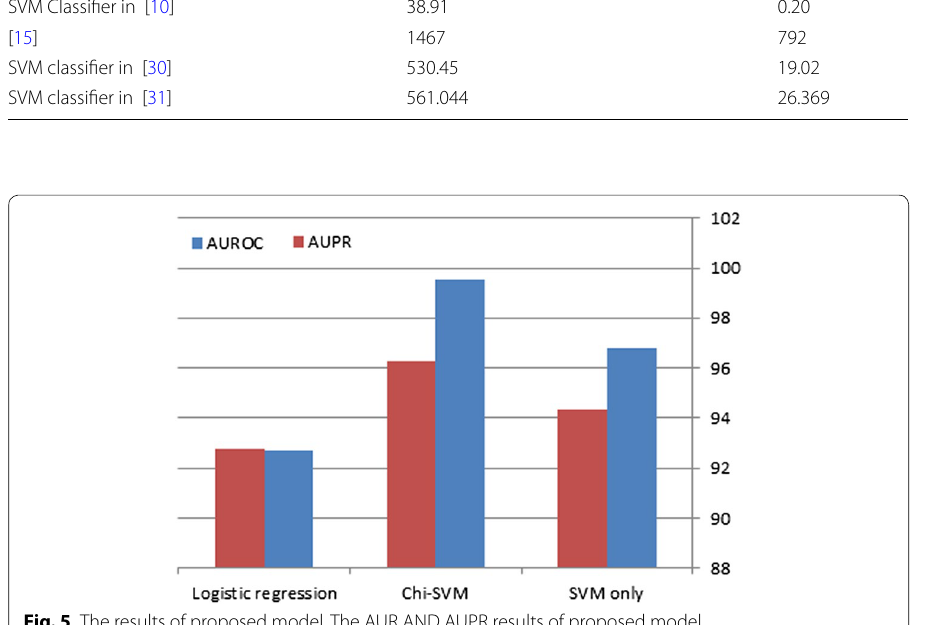
Fig. 5 The results of proposed model. The AUR AND AUPR results of proposed